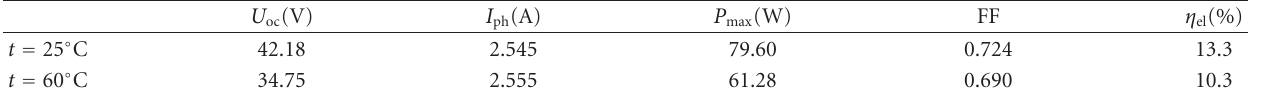
Table 1: Parameters of the ASE-100-DGL-SM module without cooling [7].